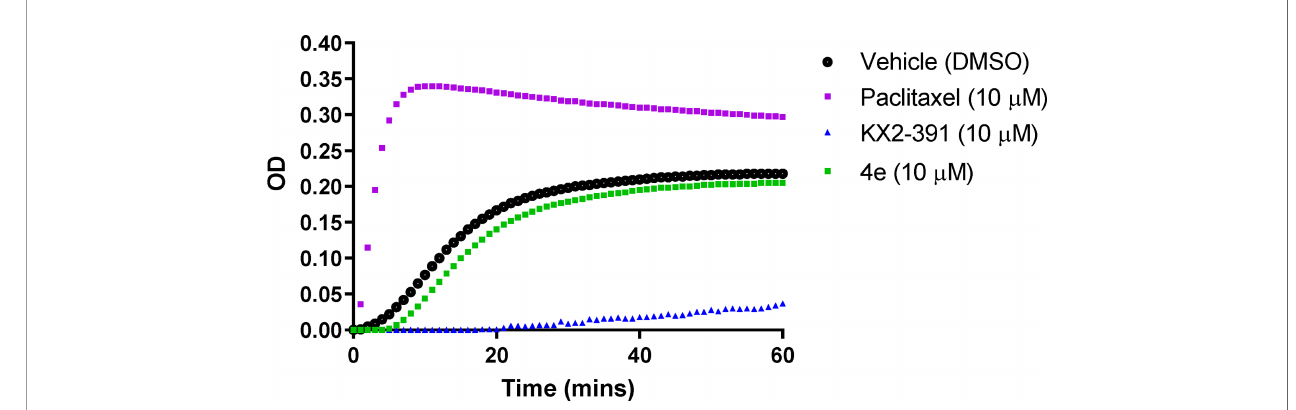
FIGURE 5 | Tubulin polymerization assay for compound 4e at 10 µM compared to paclitaxel (10 µM) and KX2-391 (10 µM) as references, while DMSO (1% v/v) was used as a vehicle control. Puri fi ed bovine tubulin and GTP were mixed in a 96-well plate. The polymerization reaction was initiated by warming the solution from